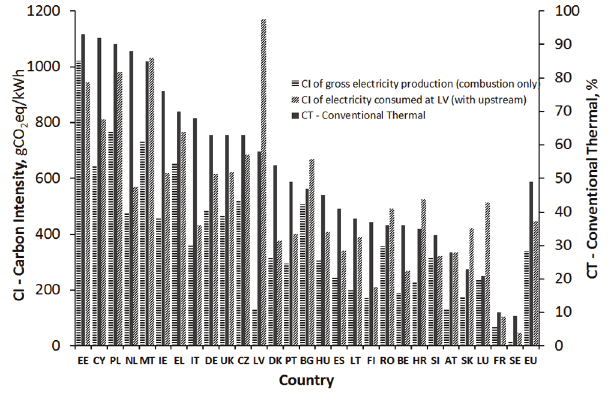
Fig. 2. Carbon intensity by production and use of electricity in EU countries The data primarily indicate that centralized electricity generation and distribution systems cause large losses in energy transmission – which means a significant increase in specific CO emissions (in g 2 eq